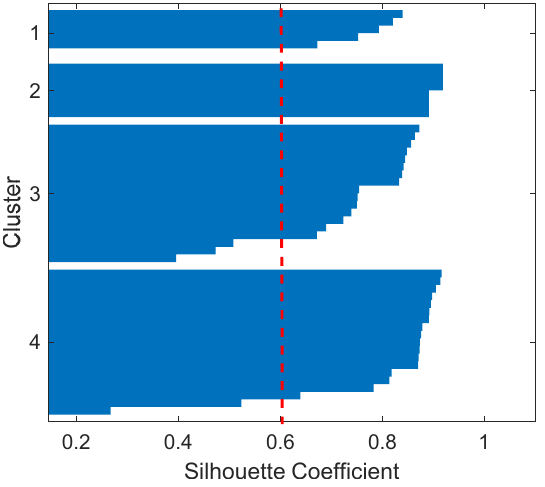
Figure 8. Silhouette coefficient values of clustering = 4.